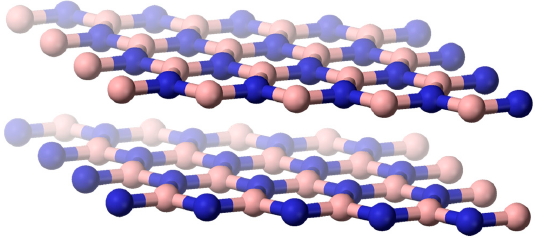
Figure 5. Representation of the structure of hexagonal boron nitride, the nitrogen atoms are represented in blue, and the boron atoms in pink.